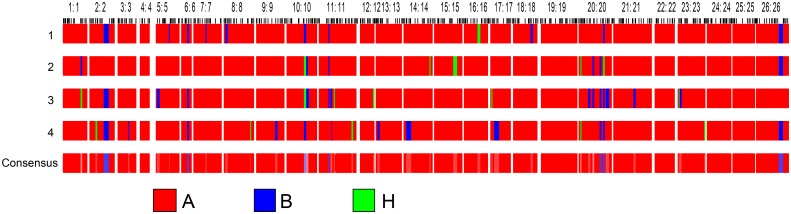
Introgressed Hai1 chromosome segments in the parents.1: MBI9804; 2: MBI9855; 3: MBI9752; and 4: MBI9134; A: genome of recurrent parent CCRI36; B: homologous Hai1 segments; H: heterozygous Hai1segments.